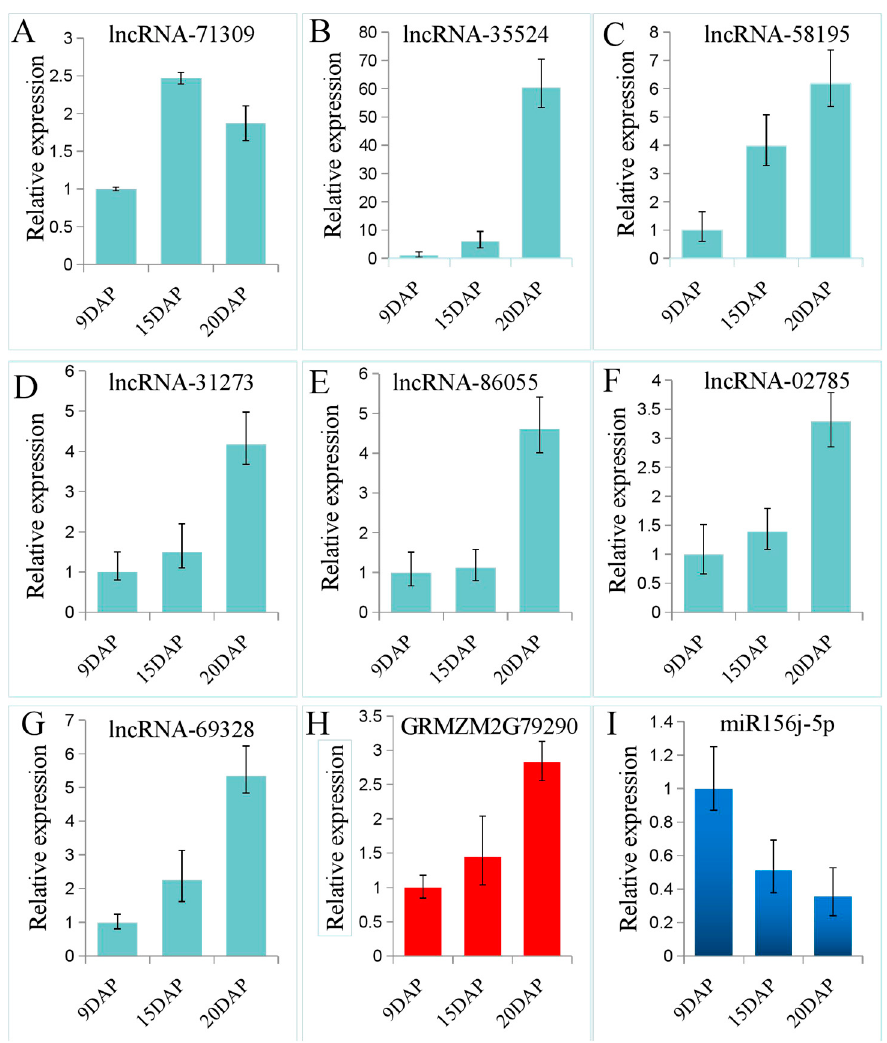
Figure 5. Co ‐ expression network of lncRNA ‐ miRNA ‐ mRNA and ceRNA. The network was constructed based on ceRNA score (score ≥ 1, p ‐ value < 0.01). Diamond nodes represent miRNAs, circles represent mRNAs, and rectangles represent lncRNAs.